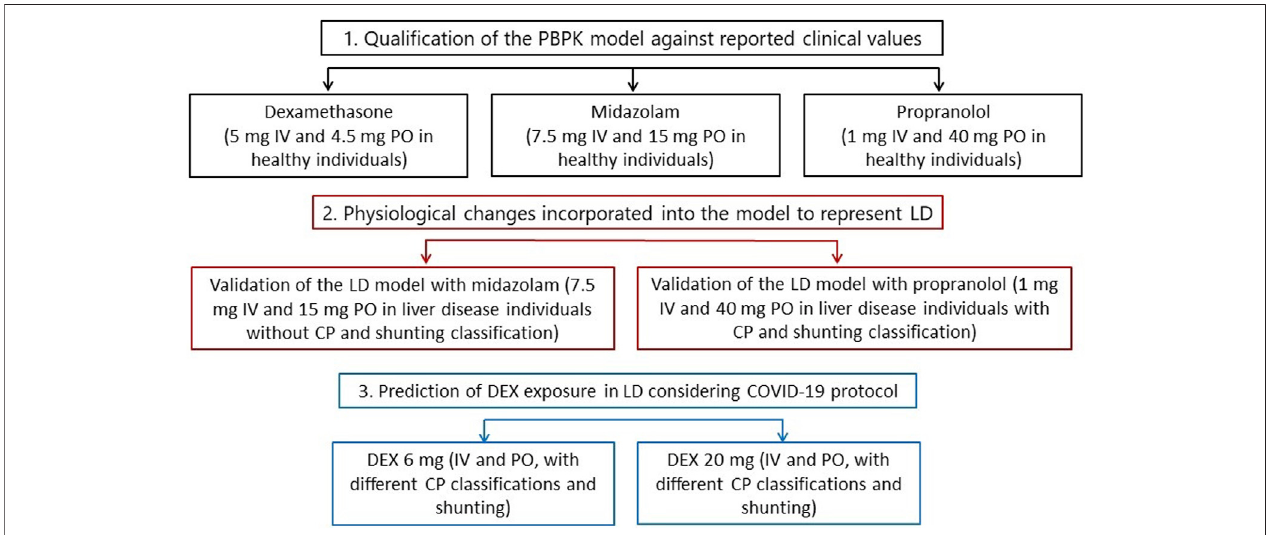
FIGURE 1 | Overall step-by-step work fl ow representing the PBPK modelling quali fi cation and predictions. IV, intravenous. PO, oral. LD, liver disease. CP, Child- Pugh. DEX, dexamethasone.